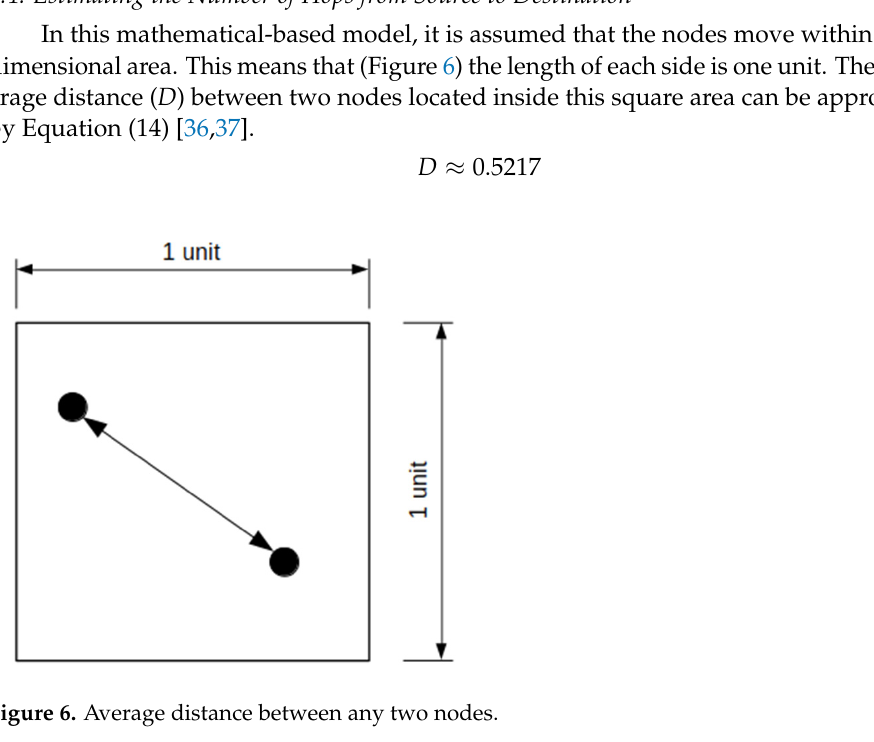
Figure 7. Number of hops representing the expected distance between any two nodes.